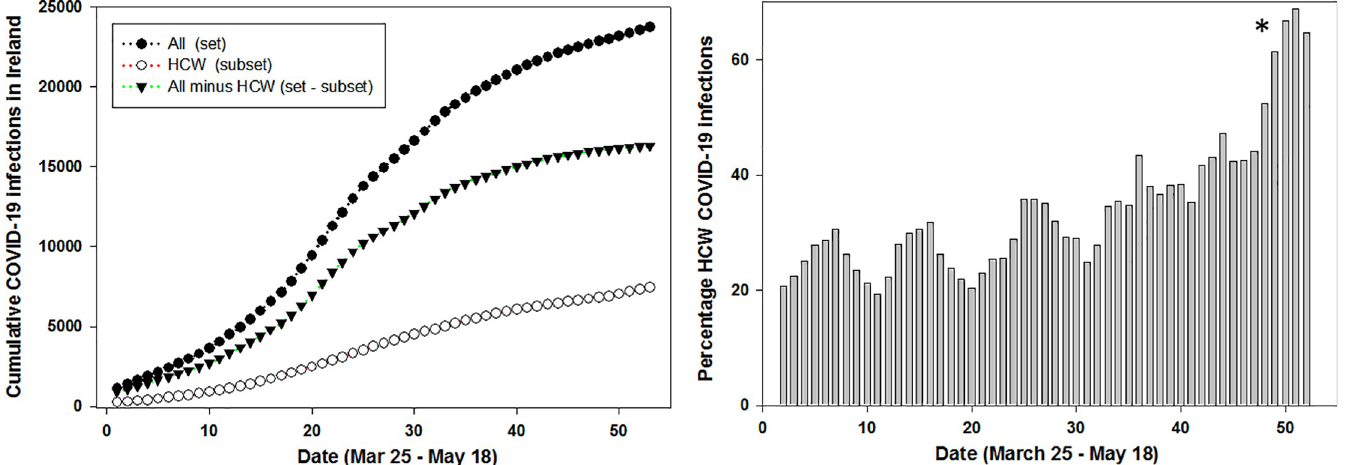
Fig 5. Left: Cumulative daily COVID-19 infections for Ireland (set, black circles), HCWs (subset, open circles), all infections minus HCW infections (set–subset, triangles) between Mar 25—May 18 in Ireland. Right: Daily percentage contribution of the HCW subset to the set of all infections between Mar 25—May 18 in Ireland. � Reference [18].